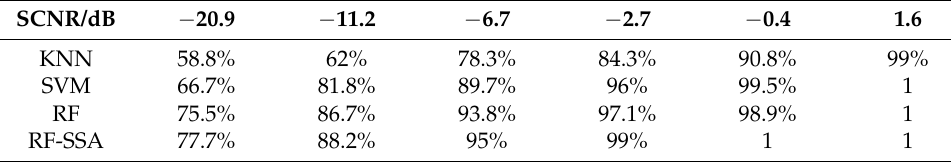
Table 4. Comparisons of AUC ( v = 0.5).